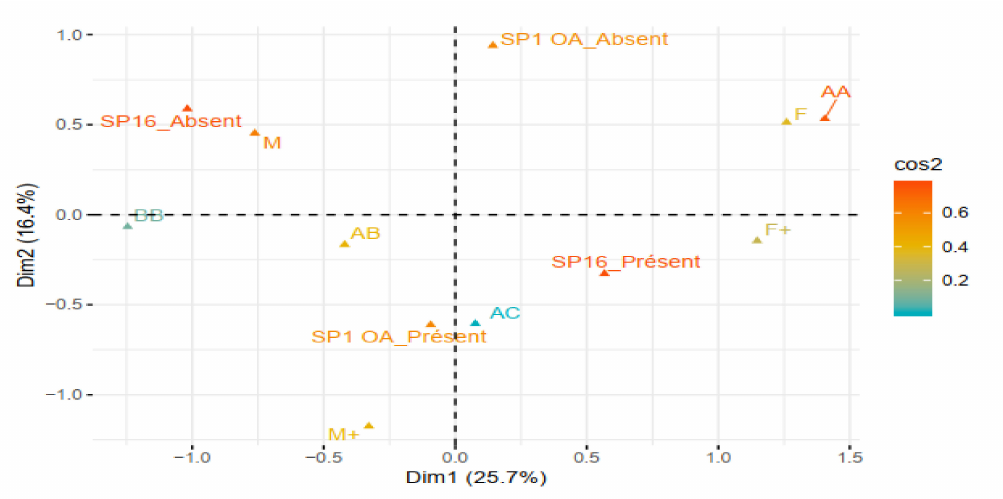
Figure 5. Multiple component analysis (MCA) of the relationship between the sex of D. rotundata cultivars from Benin and the markers sp16 and sp1. M, stable male; M + , unstable male; F, stable female; F + , unstable female; O, monoecious; N, non-flowering; and sp1 OA, presence of multiple amplifications for the sp1 marker. The color codes from red to blue (for a cos2 from the highest to the lowest) indicate the decreasing representativeness of the variables.